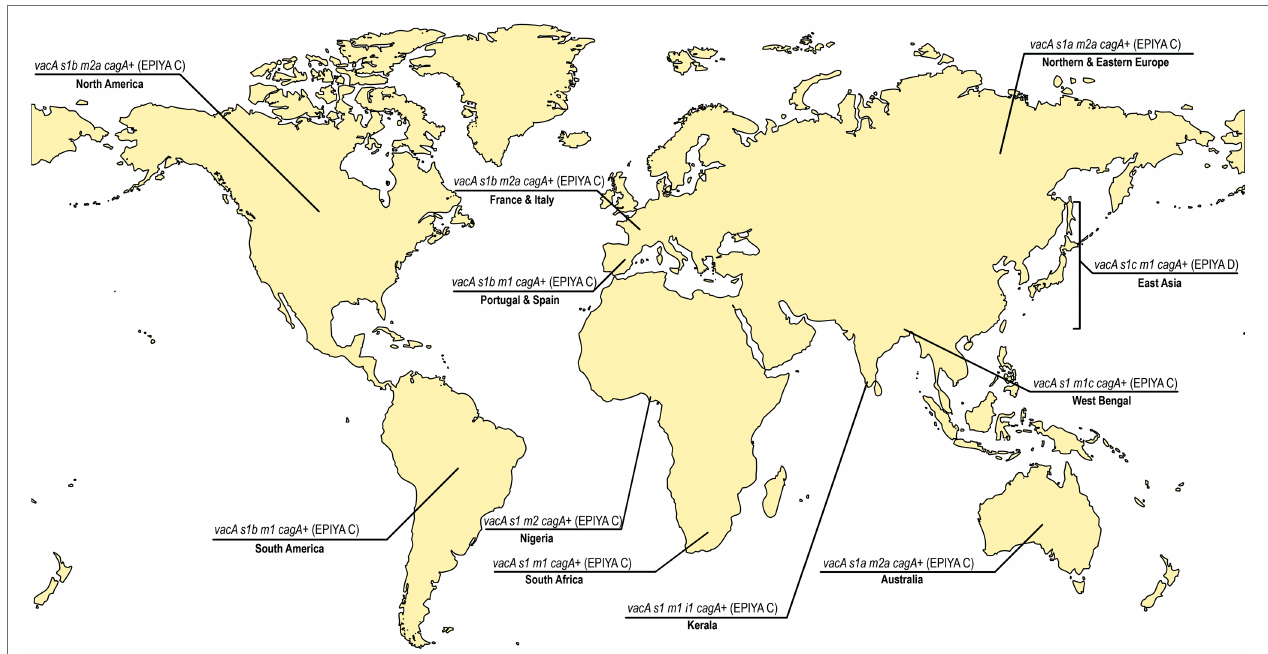
FIGURE 2 | The predominant vacA genotypes and cagA status in different regions of the world. East Asia, North America, South America, Europe (France, Italy, Portugal Spain, Northern, and Eastern Europe), Africa (Nigeria and South Africa), India (West Bengal and Kerala), and Australia (van Doorn et al., 1999a; Mukhopadhyay et al., 2000; Chattopadhyay et al., 2002; Idowu et al., 2019; Ofori et al., 2019; Devi et al., 2021). The predominant vacA genotypes vary between and within the continents. The more virulent Glu-Pro-Ile-Tyr-Ala (EPIYA)-ABD type CagA is confined to strains circulating in East Asian countries where as the EPIYA- ABC type CagA is found in rest of the countries. The age standardized incidence of gastric cancer per 100,000 individuals in different countries has previously been reported [Eastern Asia and Eastern Europe ≥ 11.1; Portugal 7.3 to11.1; Spain 5 to 7.3; France 3.8 to 5; Italy 5 to 7.3; South America 7.3 to 11.1; North America 3.8 to 5; India (except West Bengal: 5 to 7.3), Australia, South Africa: 3.8 to 5;and Nigeria: <3.8; Smyth et al.,